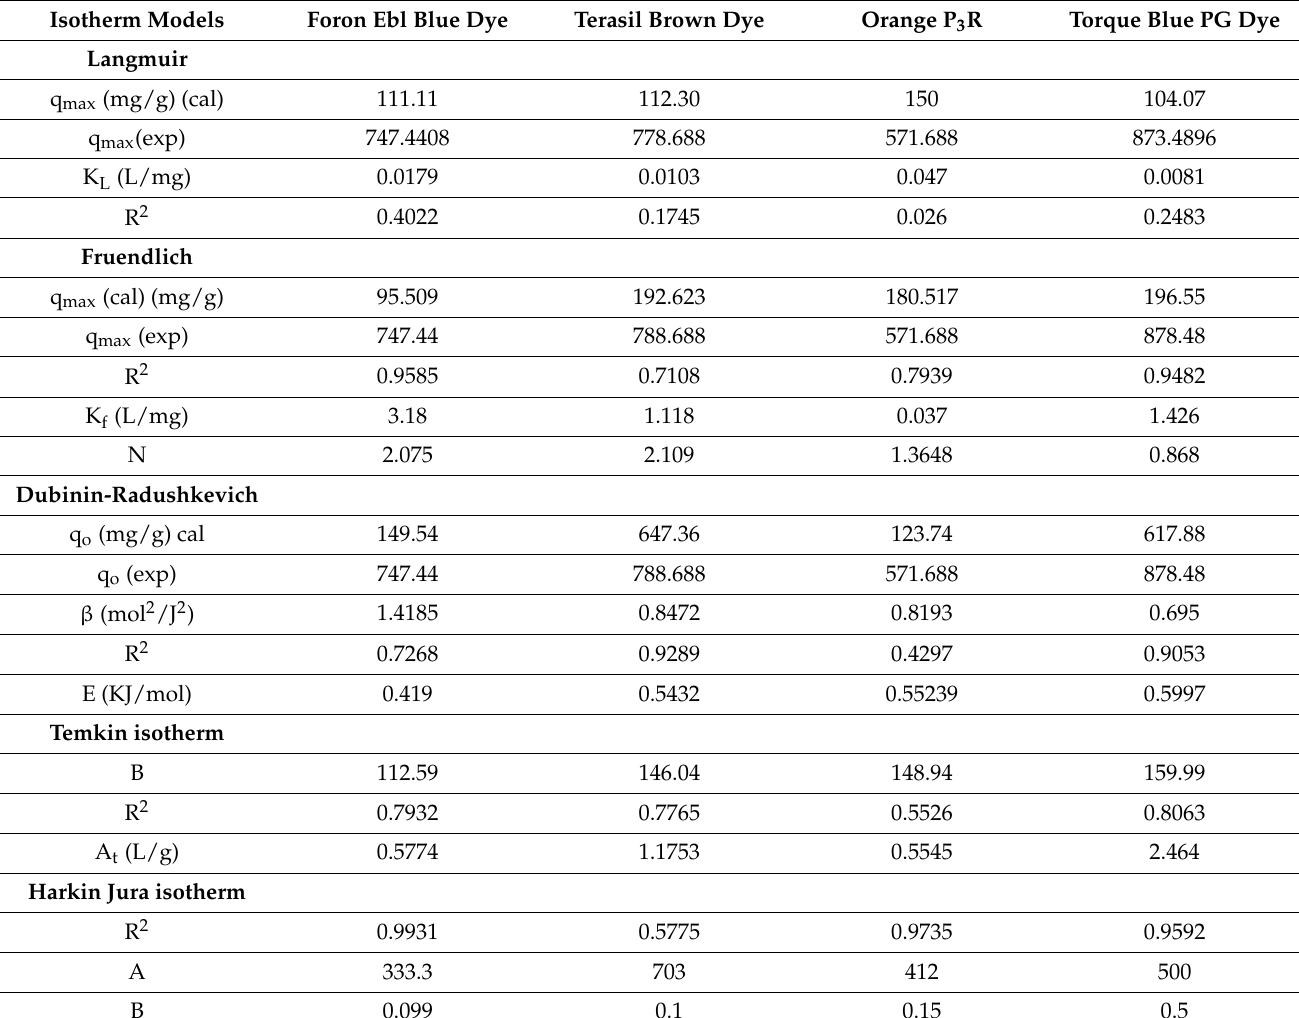
Table 1. Parameters obtained from different isothermic models using non-calcinized composites at 5, 10, 20, 25, and 50 ppm